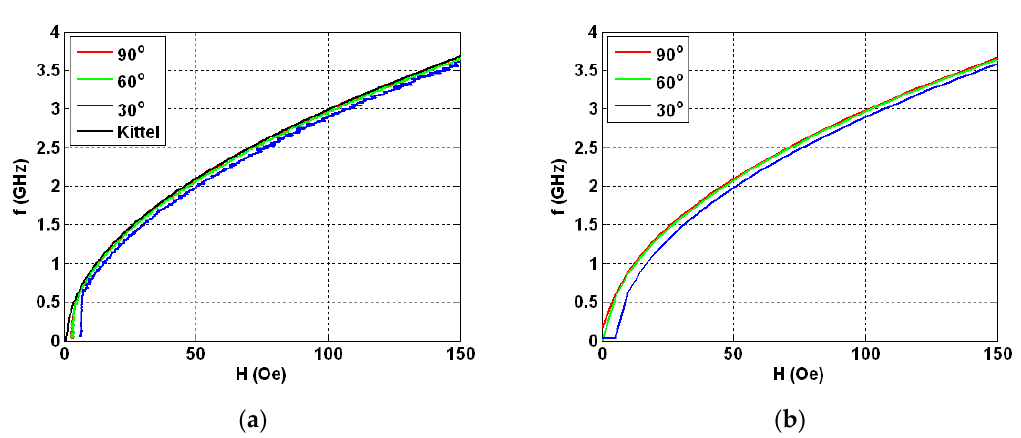
Figure 9. Experimental ( a ) and calculated ( b ) field dependences of the maximum of real part of total impedance increment for external field H directed under various angles respect to high frequency field h . Kittel equation fit is also shown for comparison together with the experimental data (part ( a )).